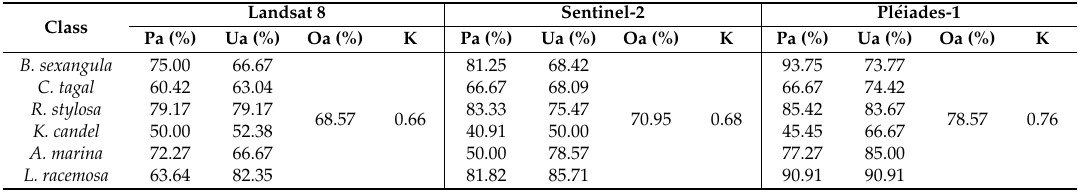
Table 8. Accuracy descriptive statistics of mangrove species at community